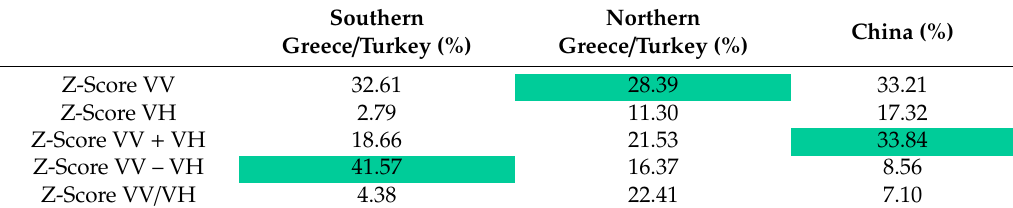
Table 5. Random forest importance analysis of the time series features for TFV and individual study areas. The rows highlighted in green represent the time series features with the highest contribution (importance).